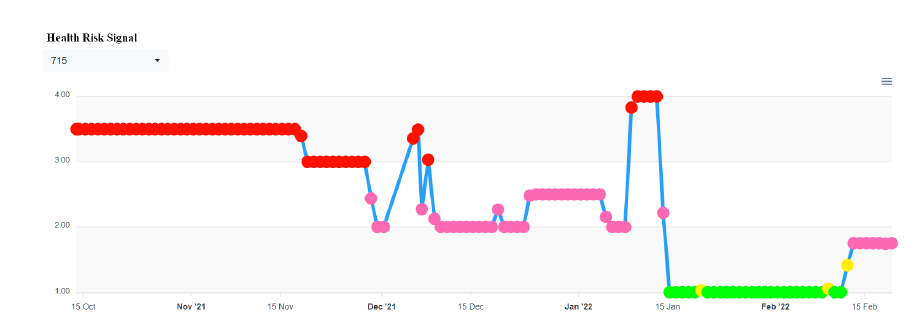
Figure 10. The abnormality record of the hot-pressing furnace.